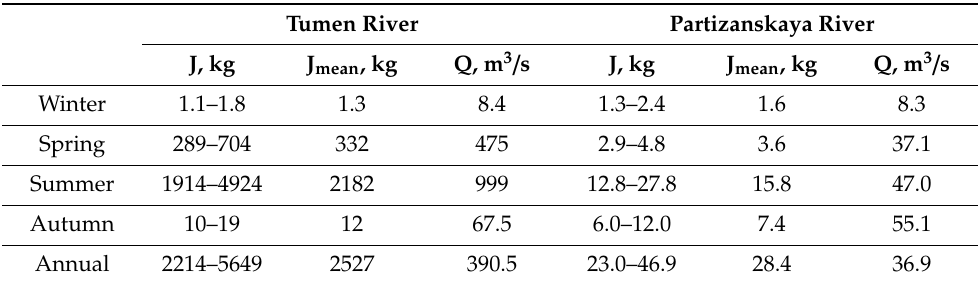
Table 4. TPAHs mass fluxes to the Sea of Japan from the Tumen River and Partizanskaya River and the mean discharge of the